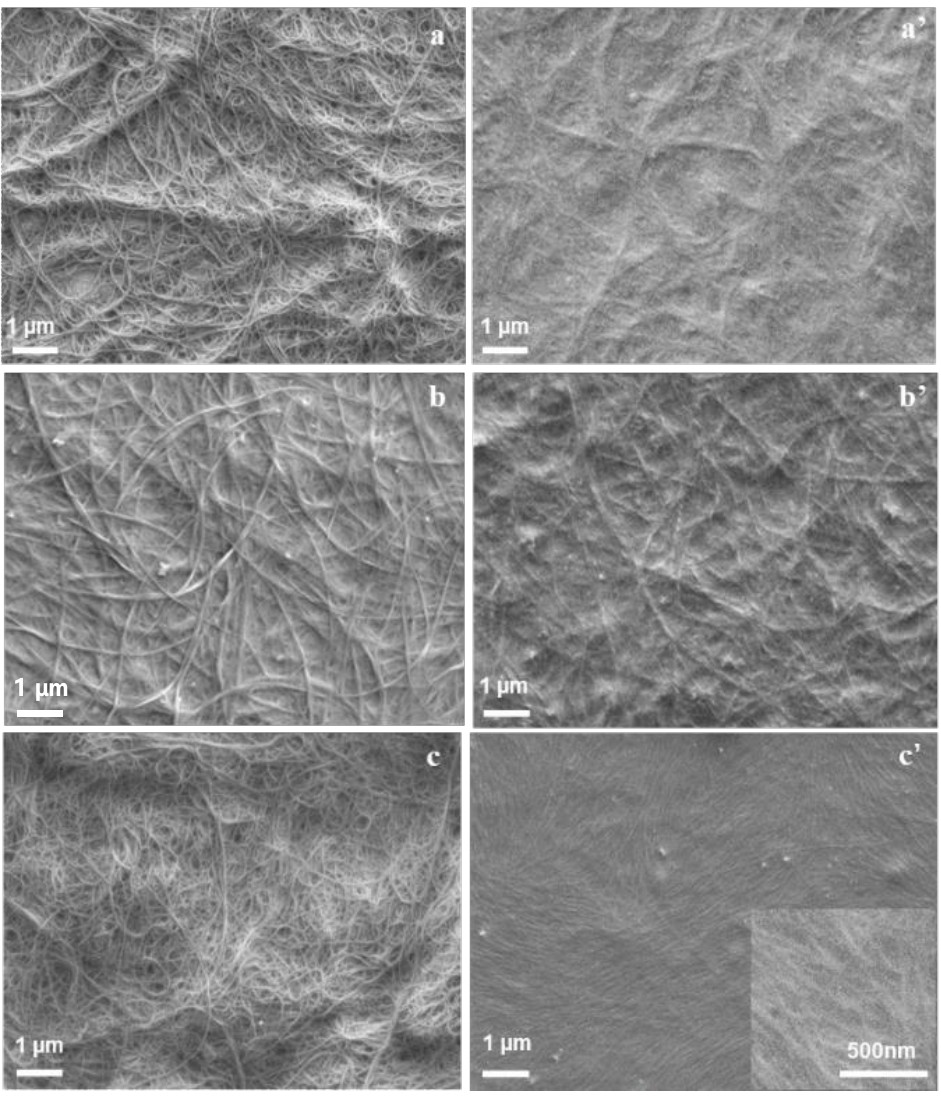
Figure 3. The surface SEM images of mix-SWNT / rr-P3DDT composite films ( a – c ) and sc-SWNT / rr-P3DDT composite films ( a’ – c’ ) with 20 wt%, 33 wt% and 50 wt% SWNT content.